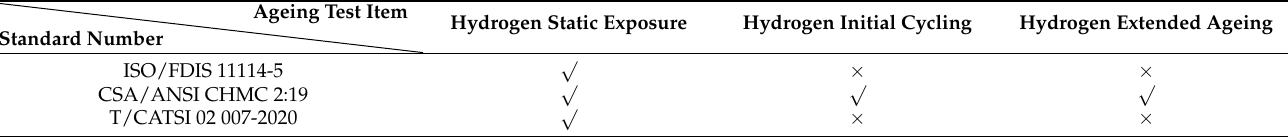
Table 4. Comparison of accelerated ageing test procedures among three existing standards.